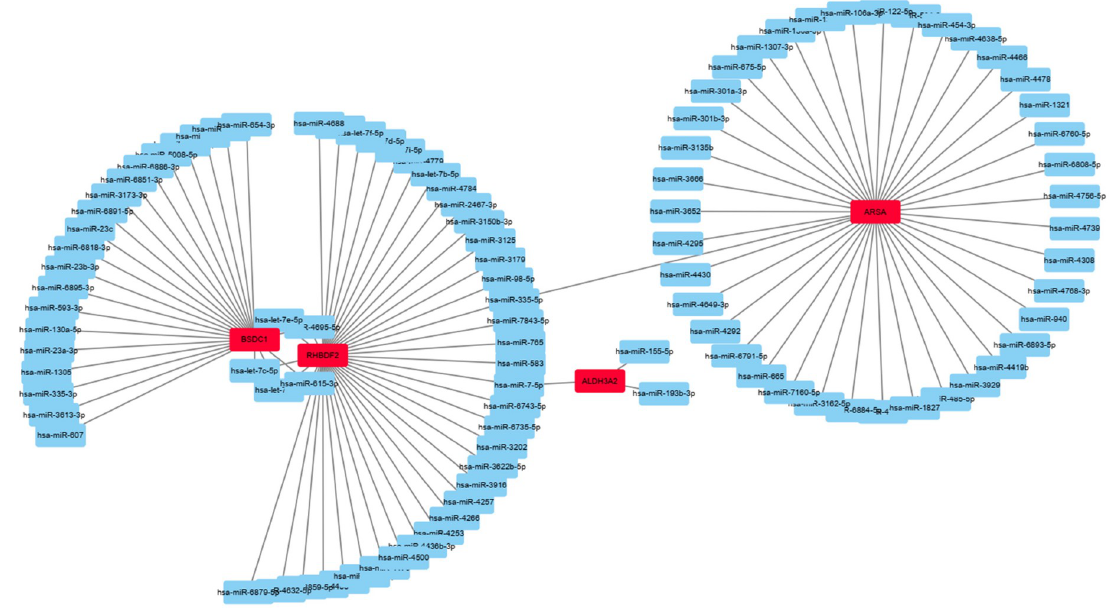
Fig 3. Correlation analysis of differentially expressed mRNA and miRNA. The genes with red color are core regulators in the network, and blue color are miRNAs selected associated with these genes.